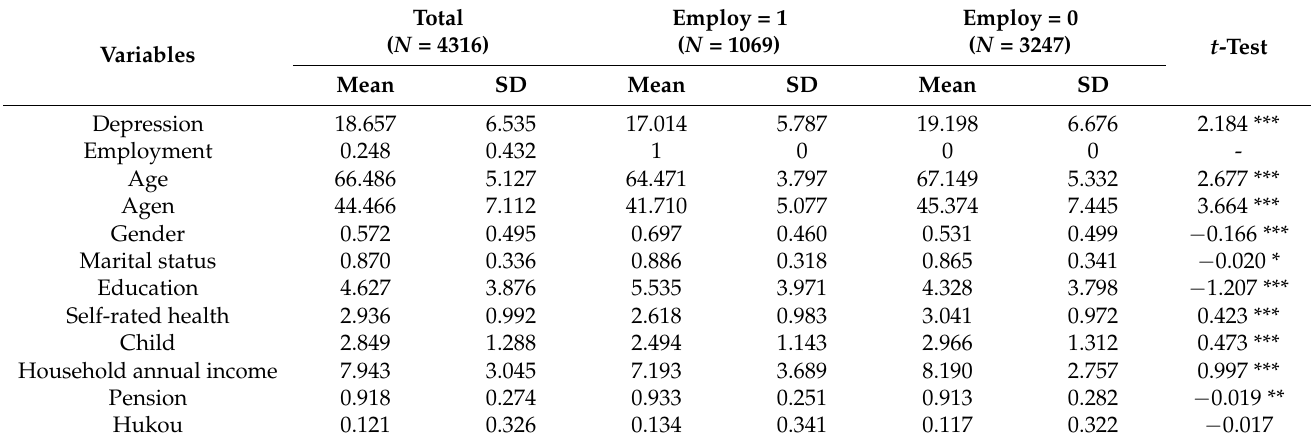
Table 2. Descriptive statistics of the